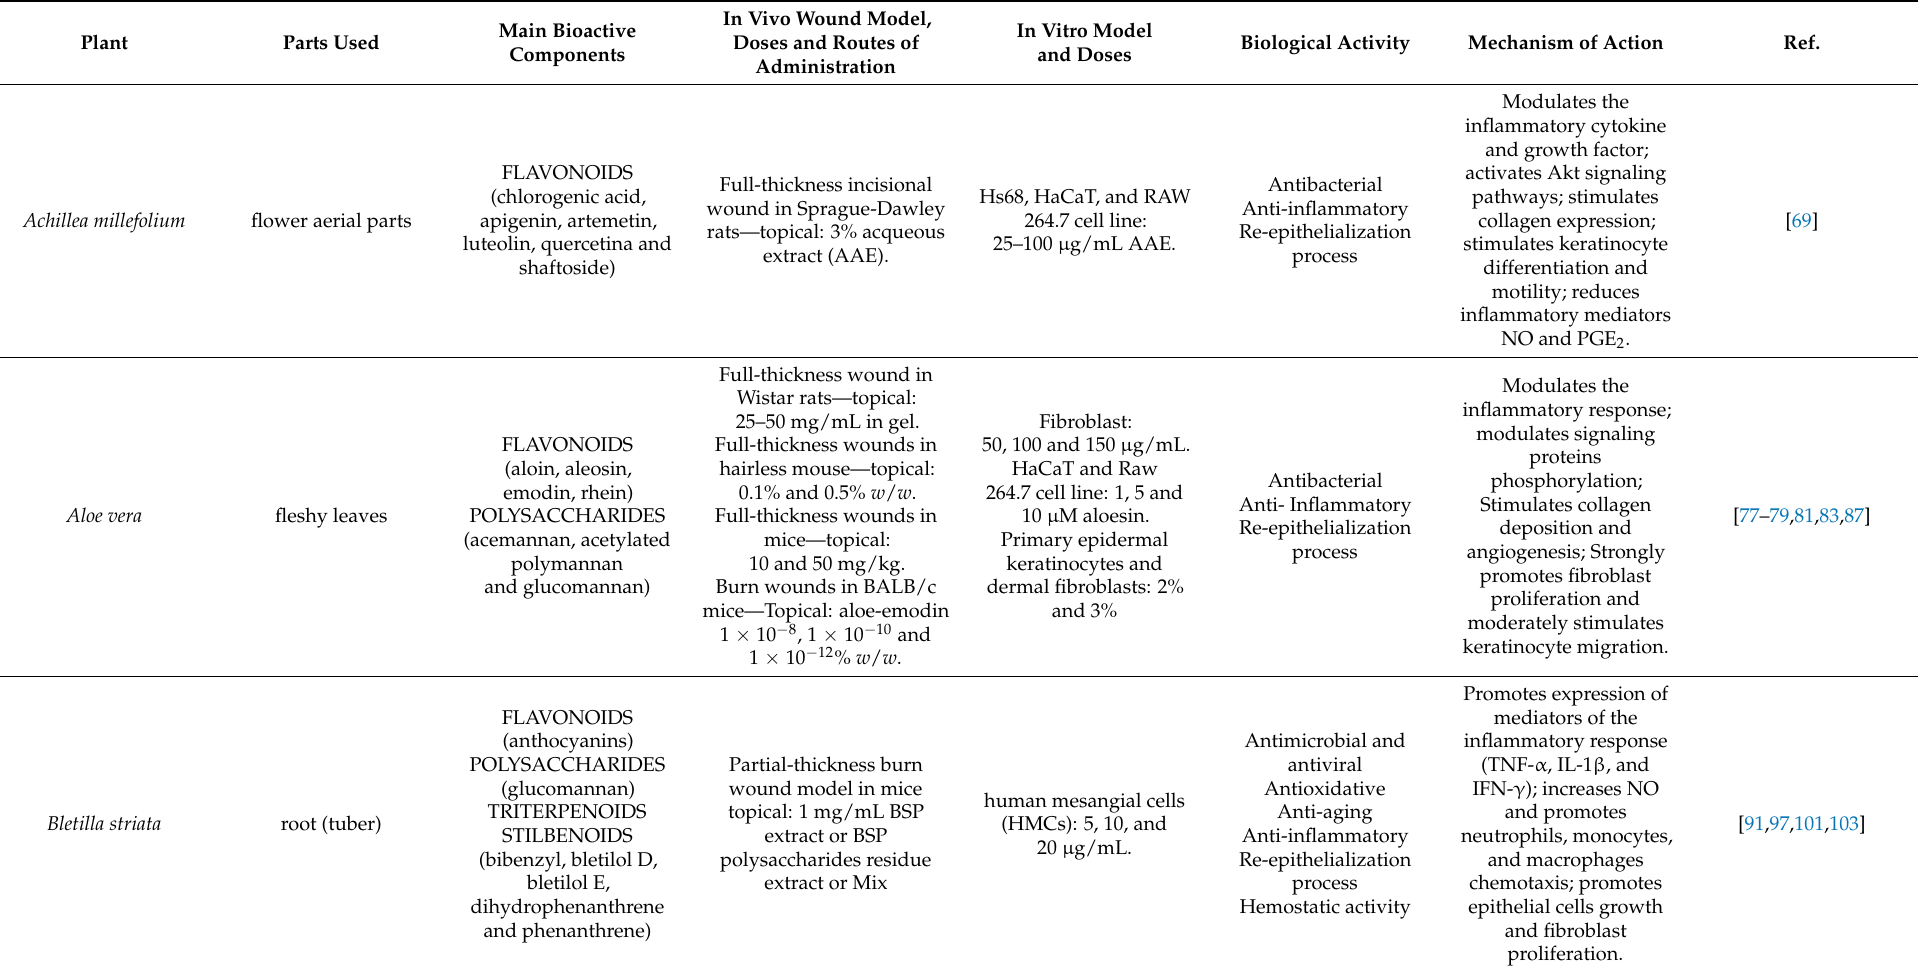
Table 1. Medical plants and their effects in wound